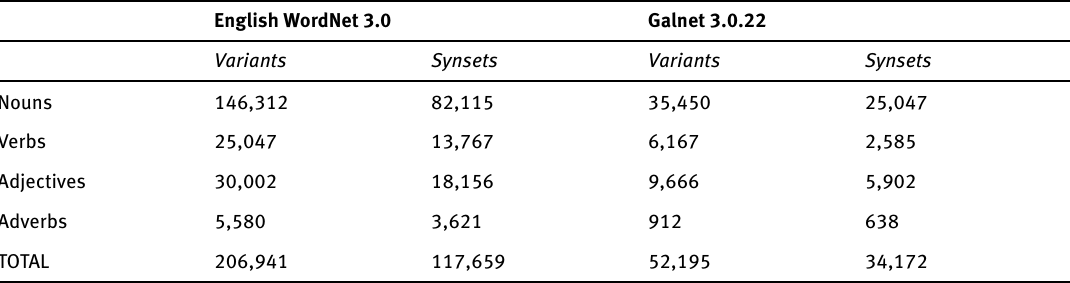
Table 1. Current Galnet Coverage (version